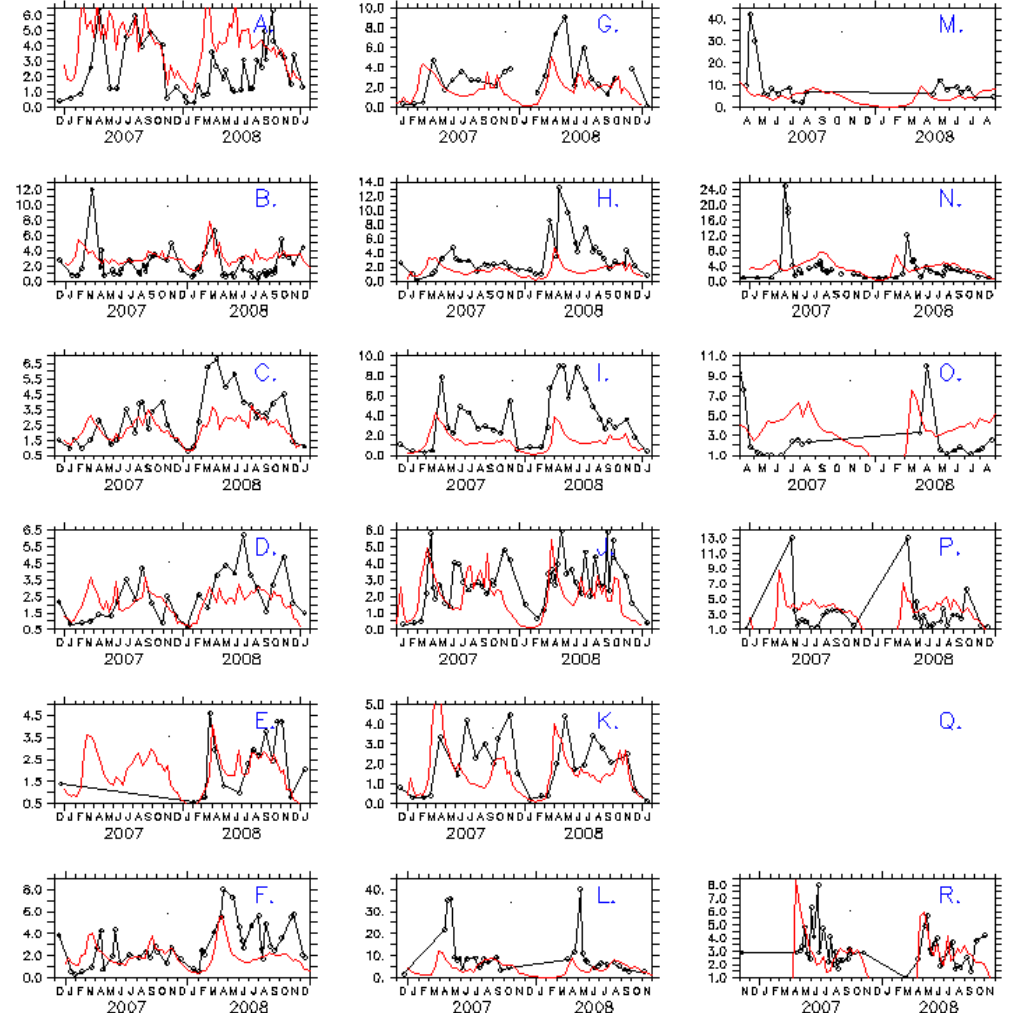
Fig. 10. Seasonal variability of Chl a in surface layer. Red solid curve (black dashed cycles) for model results (observations). Unit: mgm − 3 . Panels (A–R) for Stations A–R (Fig. 1),